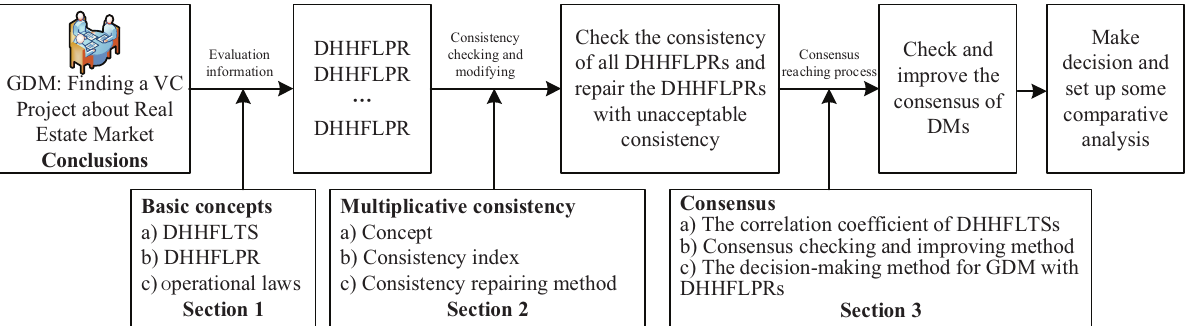
Figure 1. The main work of this